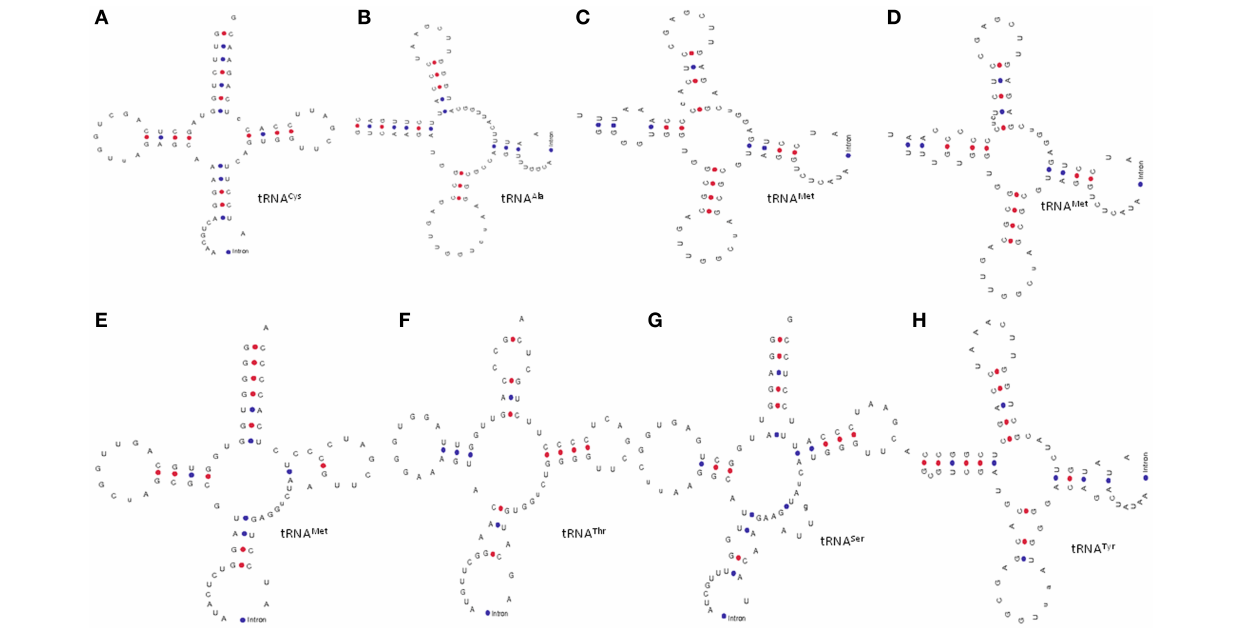
tRNA Glu contained 8, 9, or 10 nucleotides, tRNA Asn contained 7 or 9 nucleotides, tRNA Asp contained 8 or 9 nucleotides, tRNA Cys contained 7 or 9 nucleotides, tRNA Gln contained 8 or 9 nucleotides, tRNA Gly contained 7, 8, or 9 nucleotides, tRNA Thr contained 7, 8, or 9 nucleotides, tRNA Trp contained 7 or 9 nucleotides, tRNA Tyr contained 8 or 9 nucleotides, tRNA Ala and tRNA Lys contained 7 or 8 nucleotides, tRNA Ile contained 9 nucleotides and tRNA Phe contained nucleotides in the